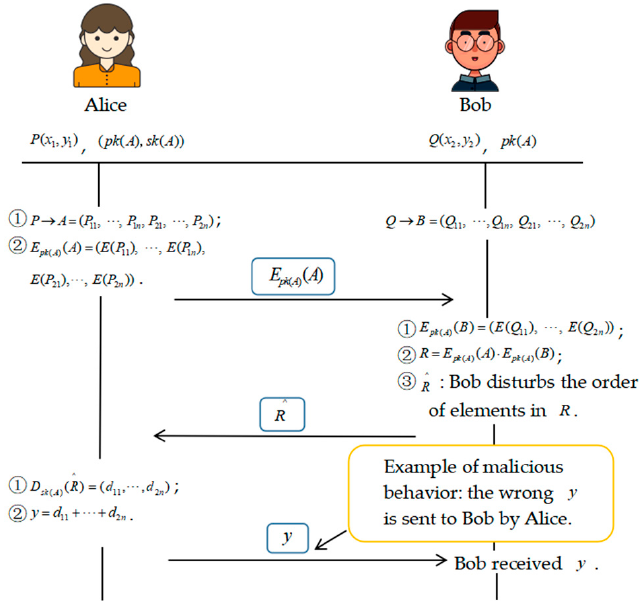
Figure 2. Example of malicious attacks in Algorithm